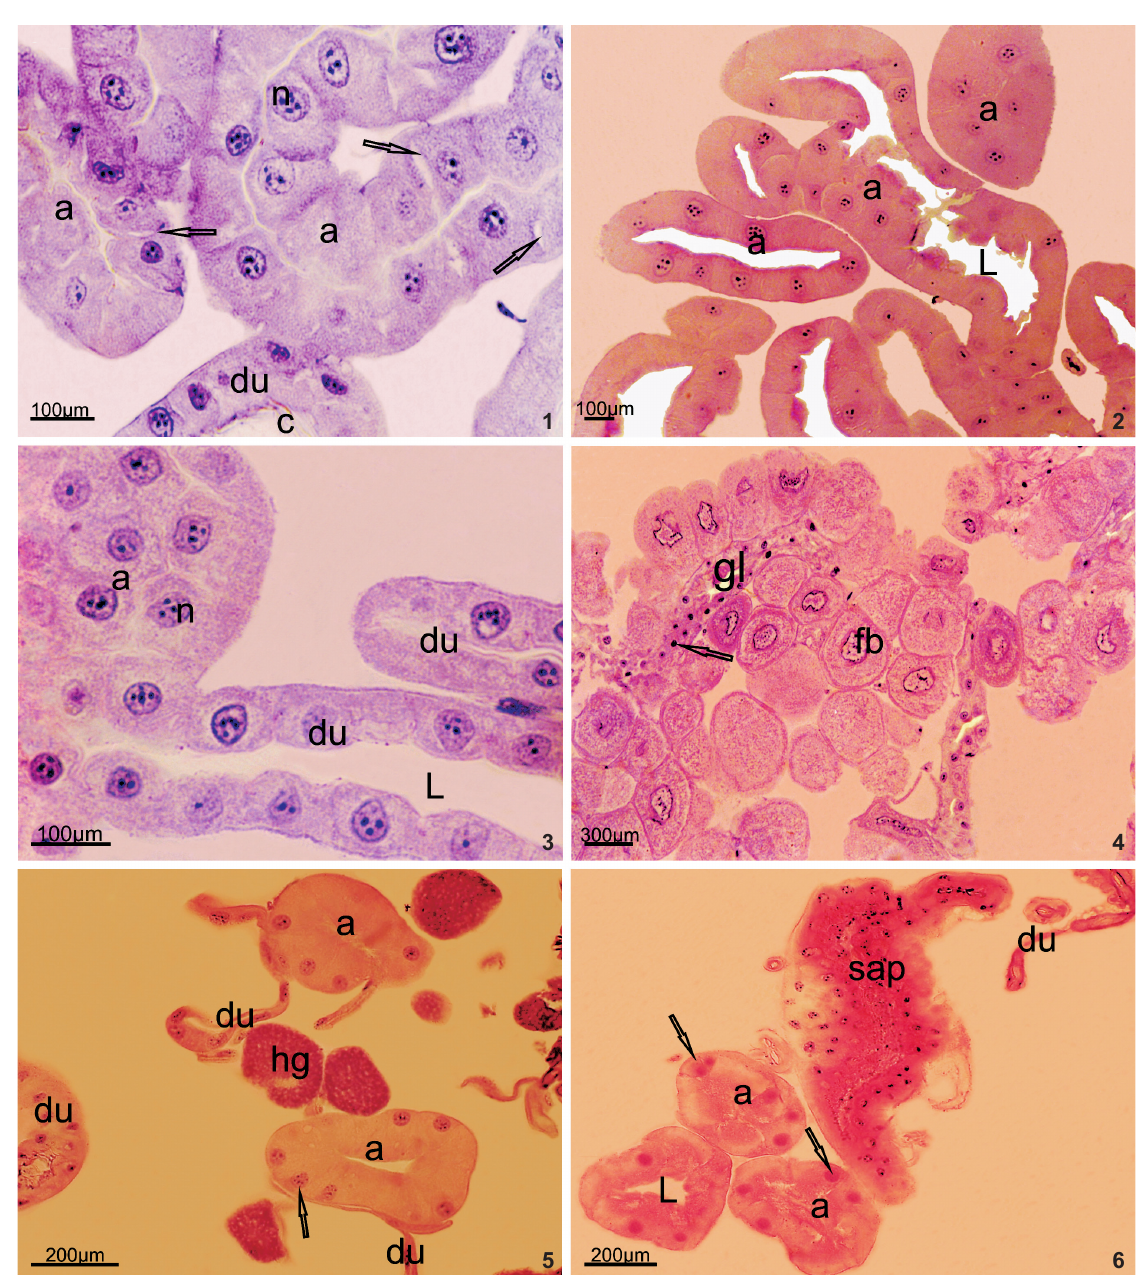
Figures 1-6. Cephalic salivary glands (CSG) stained with HE. (1-4) A. mellifera : (1) newly emerged worker showing alveoli (a) and ducts (du) with collapsed lumen, cells with central nuclei (n) and visible nucleoli. Open intercelullar spaces (arrows) and duct cuticle reinforce- ments (c). (2) CSG from forager worker showing alveolar walls consisting of cubic cells and wide alveolar lumen (L). (3) CSG form a newly emerged male showing the gland histology similar to young females, and a sexually mature male’s (4) degenerated gland (gl) showing glandular cells with picnotic nuclei (arrows), surrounded by fat body cells (fb). (5-6) Scaptotrigona postica : (5) CSG from nurse worker showing weakly stained alveolus (a) cells presenting nuclei (arrows) with nucleoli and duct (du) wall consisting of flat cells; (6) CSG from egg-laying queen showing the very acidophilic cells of the salivary pouch (sap) and alveoli (a) with cubic wall cells and homogenous nucleus (arrows). (a) Alveoli, (du) duct, (fb) fat body, (hg) hipopharingeal gland, (L) lumen, (sap) salivary